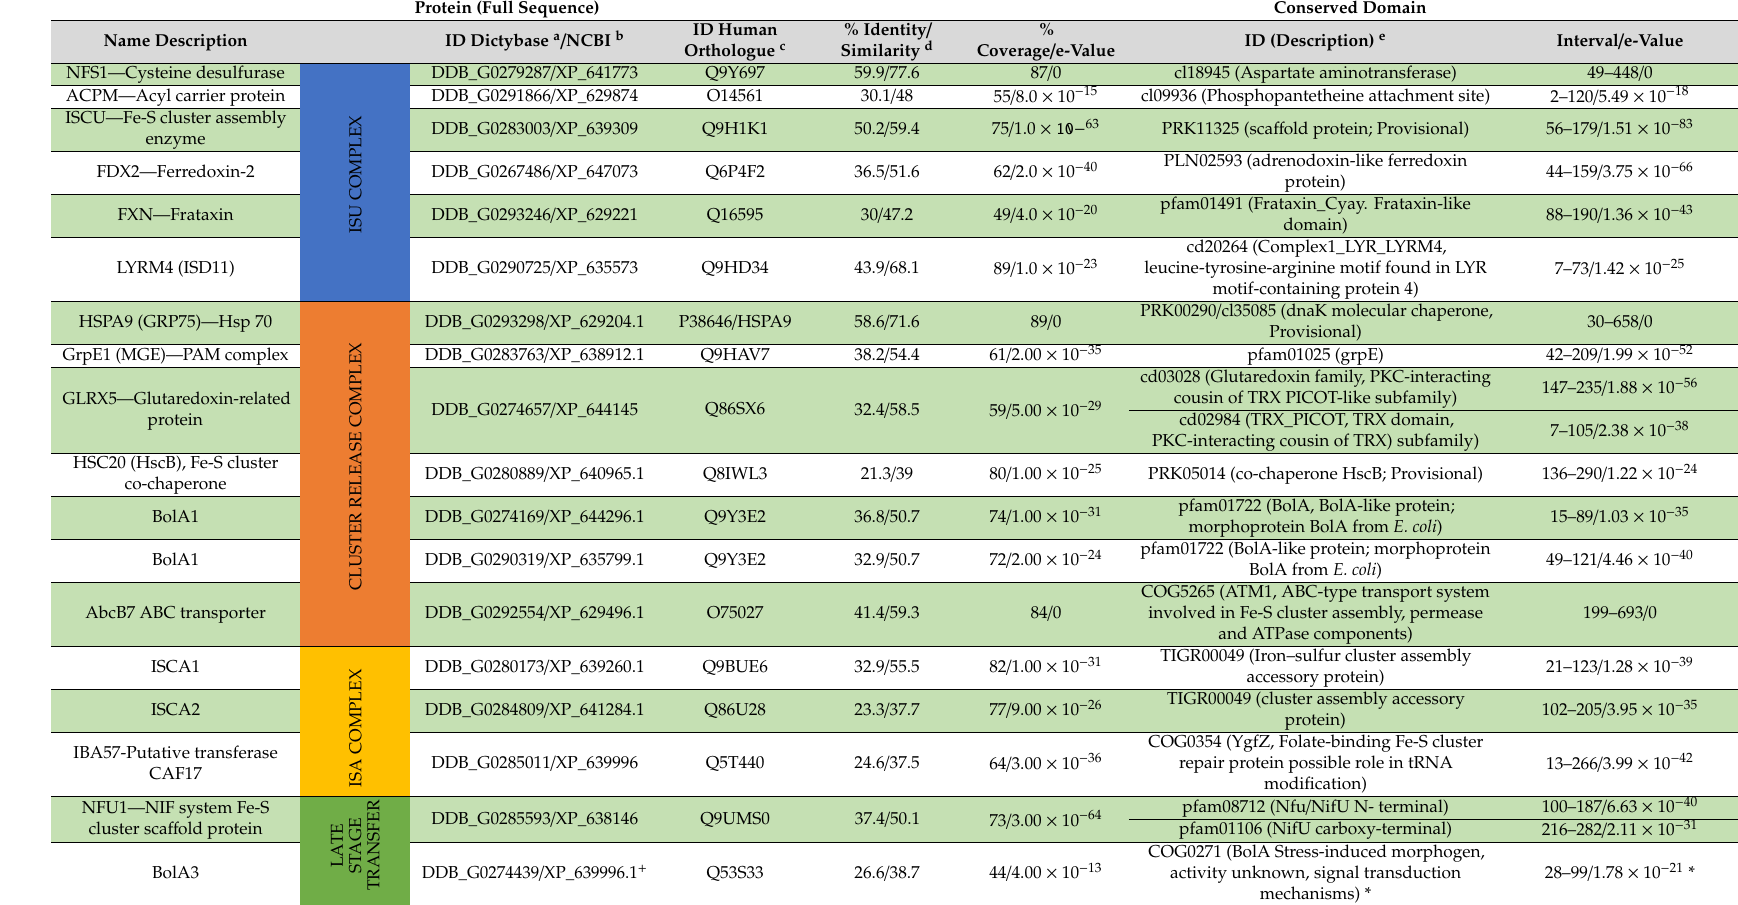
Table 1. Dictyostelium discoideum Iron-Sulfur Cluster Biogenesis